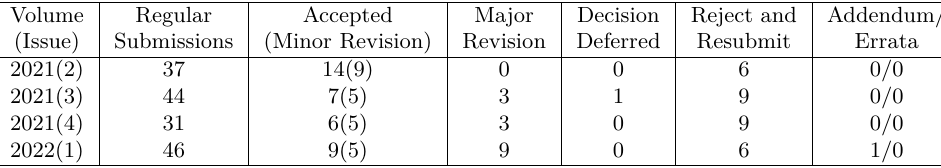
Table 1: Submission statistics for issues 2021(2), 2021(3), 2021(4), and